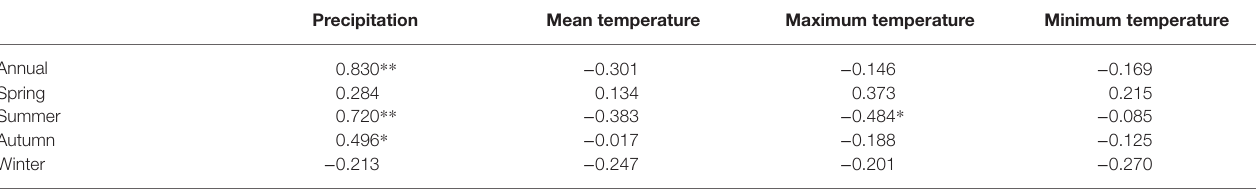
TABLE 1 | Correlation coefficients between climate variables and mean net primary productivity (NPP) over China’s temperate grasslands during 2000–2020.